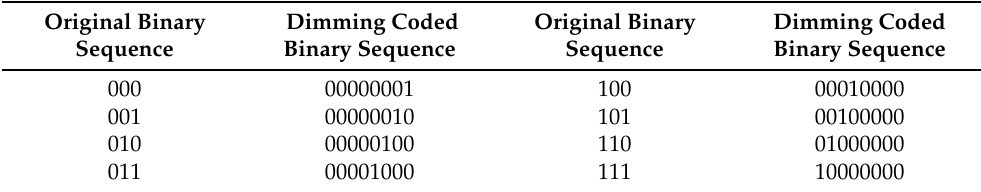
Table 1. The mapping between the original binary sequence and the dimming coded binary sequence with k = 3, n = 8, and γ = 1/8.